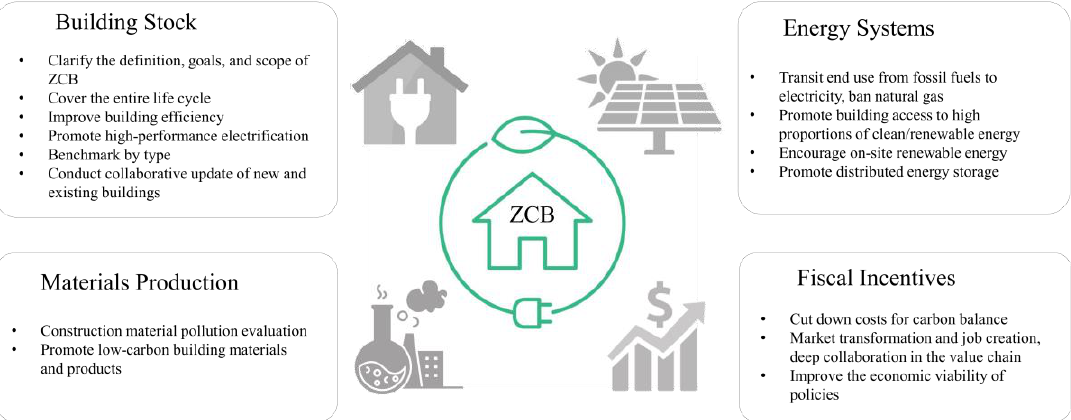
Figure 5. Highlights of policies related to ZCBs.